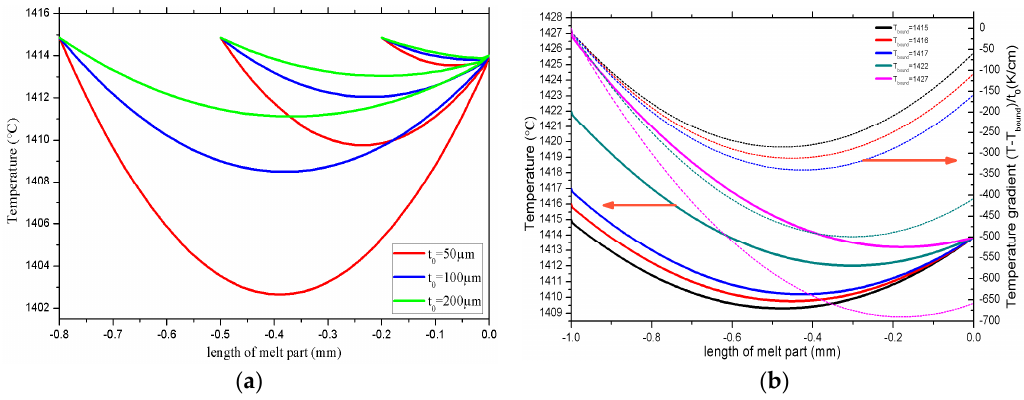
Figure 6. ( a ) Relationship between thermal profile in melt and different length with different initial thickness. ( b ) Influence to thermal profile in melt caused by different boundary temperature when initial thickness t 0 = 200 µ